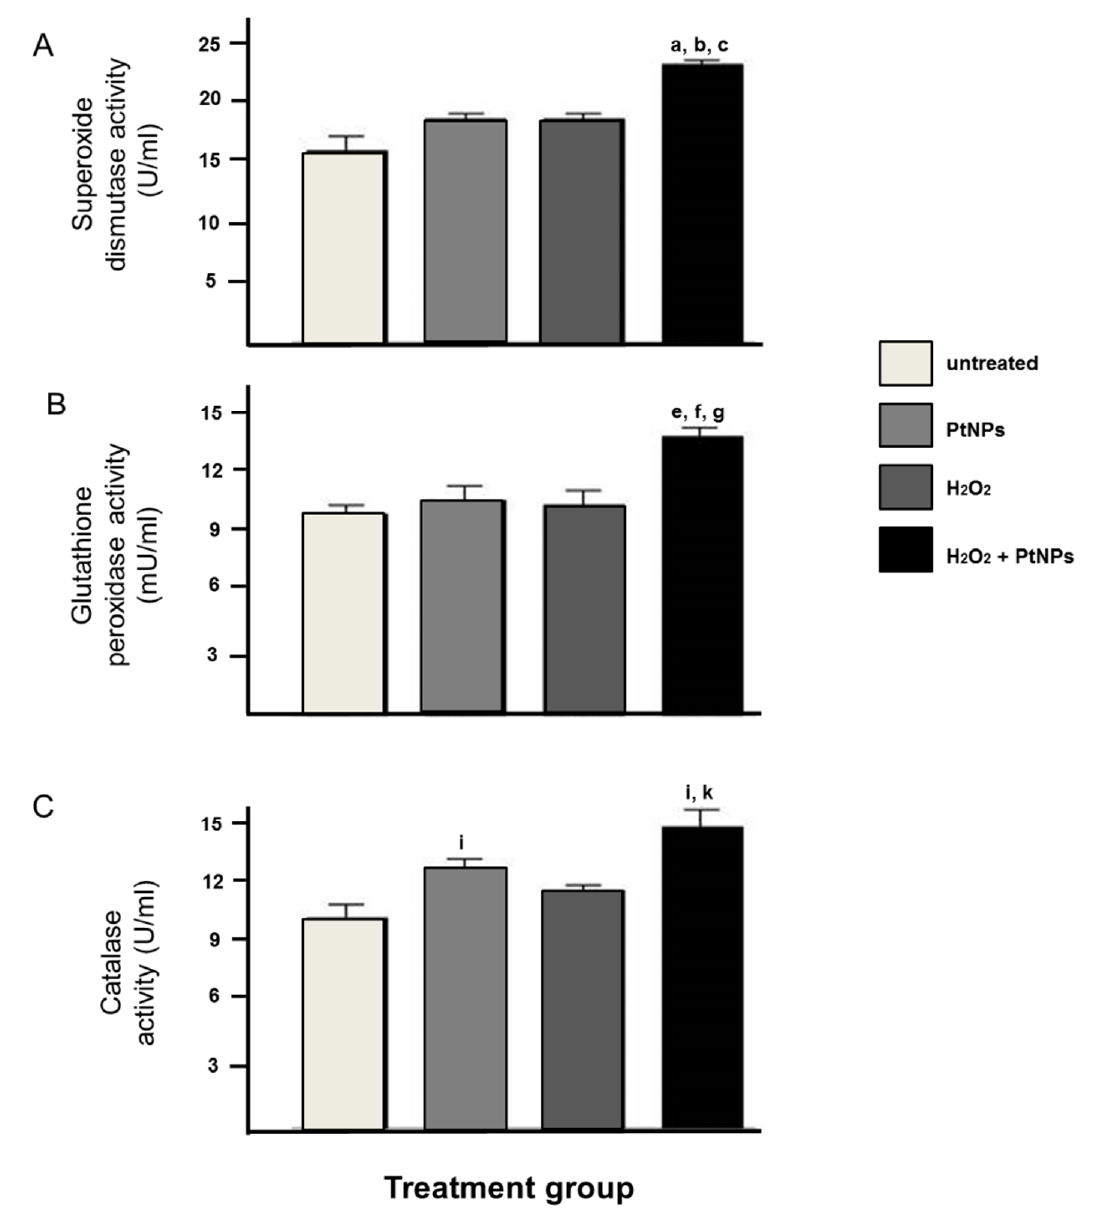
Figure 3. Cells were treated with H 2 O 2 and PtNPs for 3 h and subjected to the level of antioxidants activity. PtNPs were shown to increase the activity of antioxidants enzymes of ( A ) superoxide dismutase, ( B ) glutathione peroxidase, and ( C ) catalase activities. A statistically significant difference ( p < 0.05) denoted in alphabet a–c ( A ), e–g ( B ), and i, k ( C ) that represents a comparison between a group to, a/e/i: untreated cells, b/f: PtNPs, and c/g/k: H 2 O 2 .